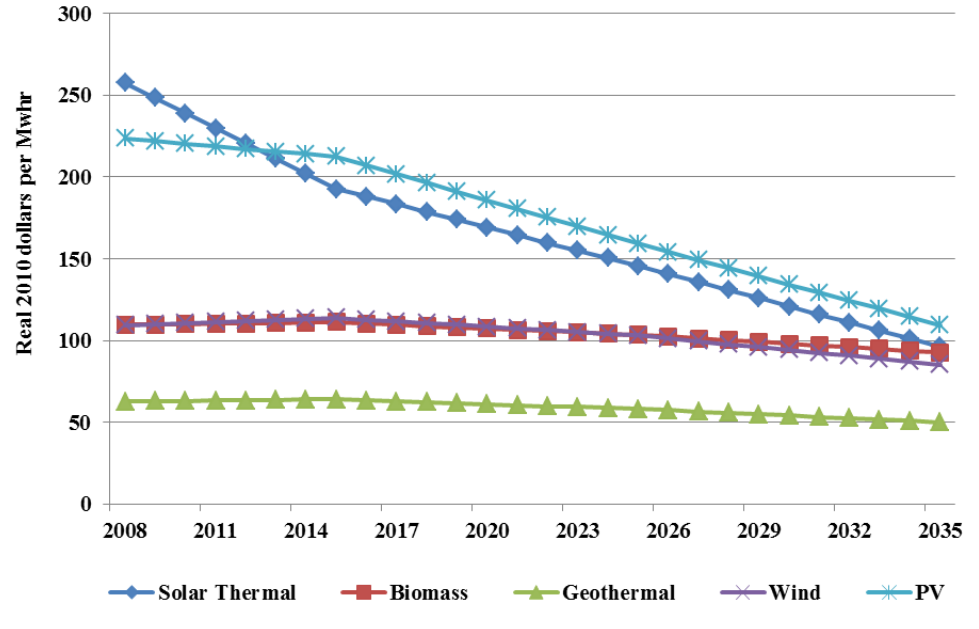
Figure 3. Levelized costs of renewable generation capacity.